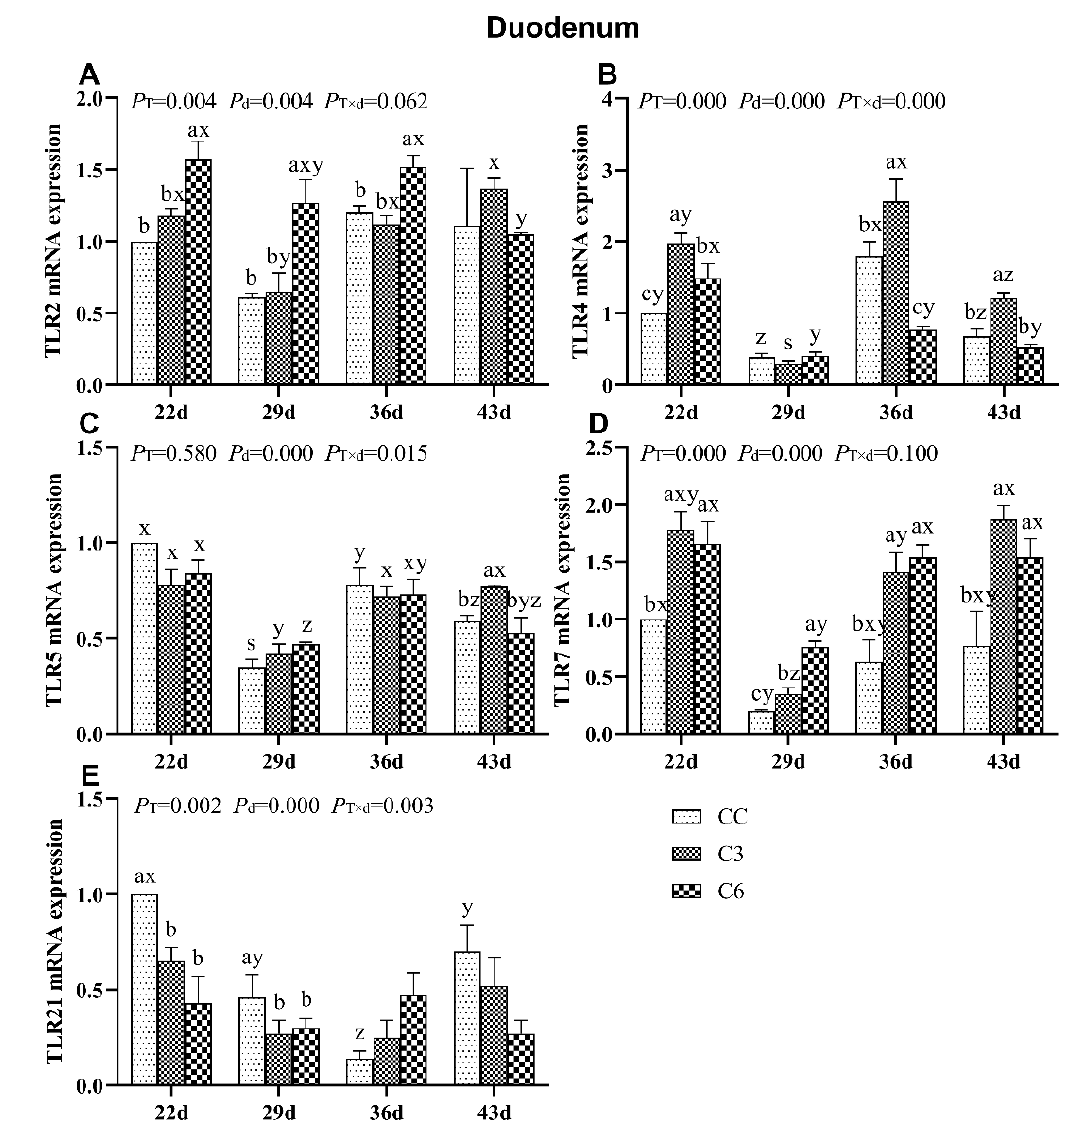
Figure 6. mRNA levels of Toll-like receptors TLR2 ( A ), TLR4 ( B ), TLR5 ( C ), TLR7 ( D ), and TLR21 ( E ) in the duodenum of broilers. Different letters indicate significant differences ( p < 0.05) between treatment groups (a, b, c, d) and days of age (x, y, z, s). TLR2 mRNA levels in C6 on days 22, 29, and 36 were significantly higher than in C3 and CC ( p < 0.05, Figure 6A). TLR2 mRNA expression in C3 decreased from days 22 to 29 and then increased on day 36, but no trend for TLR2 mRNA expression was found in C6 and CC with age